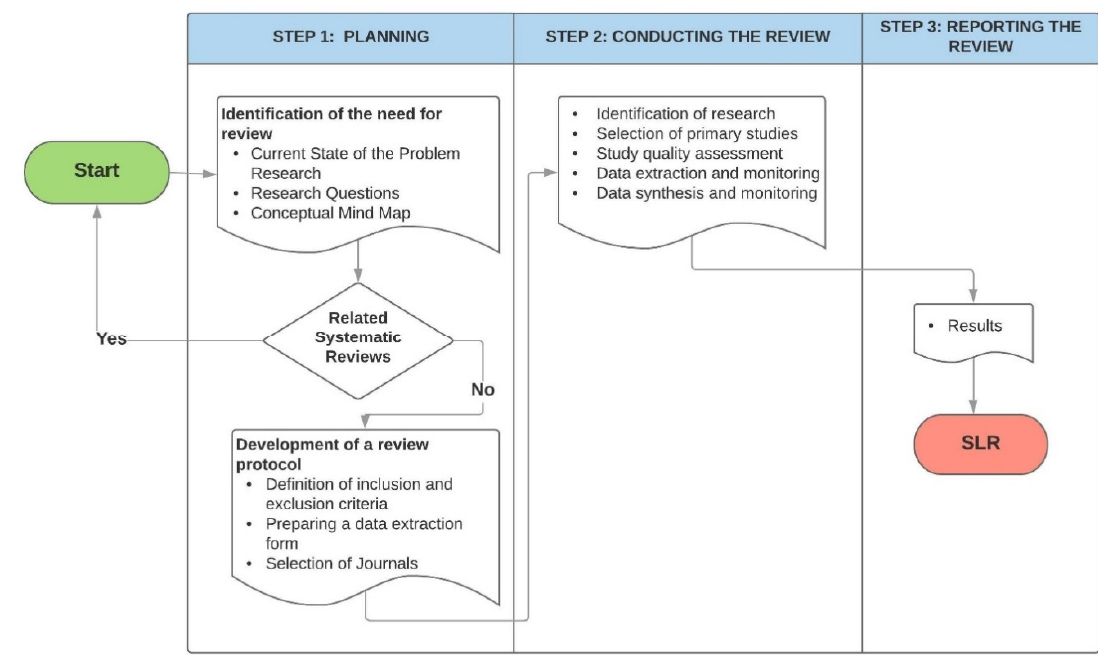
Figure 3. Flow diagram of the methodology.